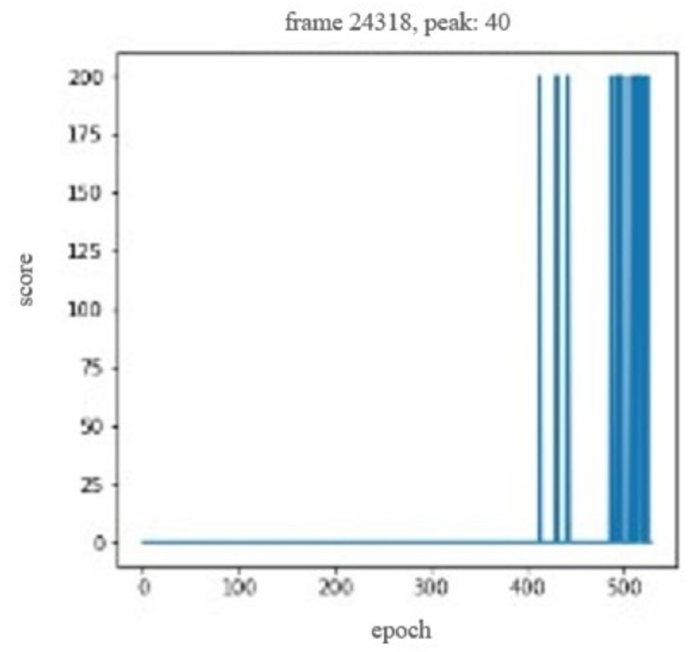
Figure 13. Soft Q-function (Q) imitation learning training graph for a pouring task.